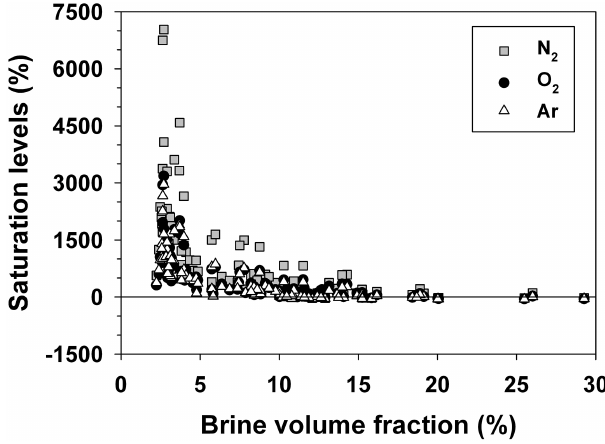
Figure 4. Saturation levels ( 1 C i in Eq. 1, in percentage) of N 2 , O 2 and Ar (squares, circles and triangles respectively) compared to the brine volume